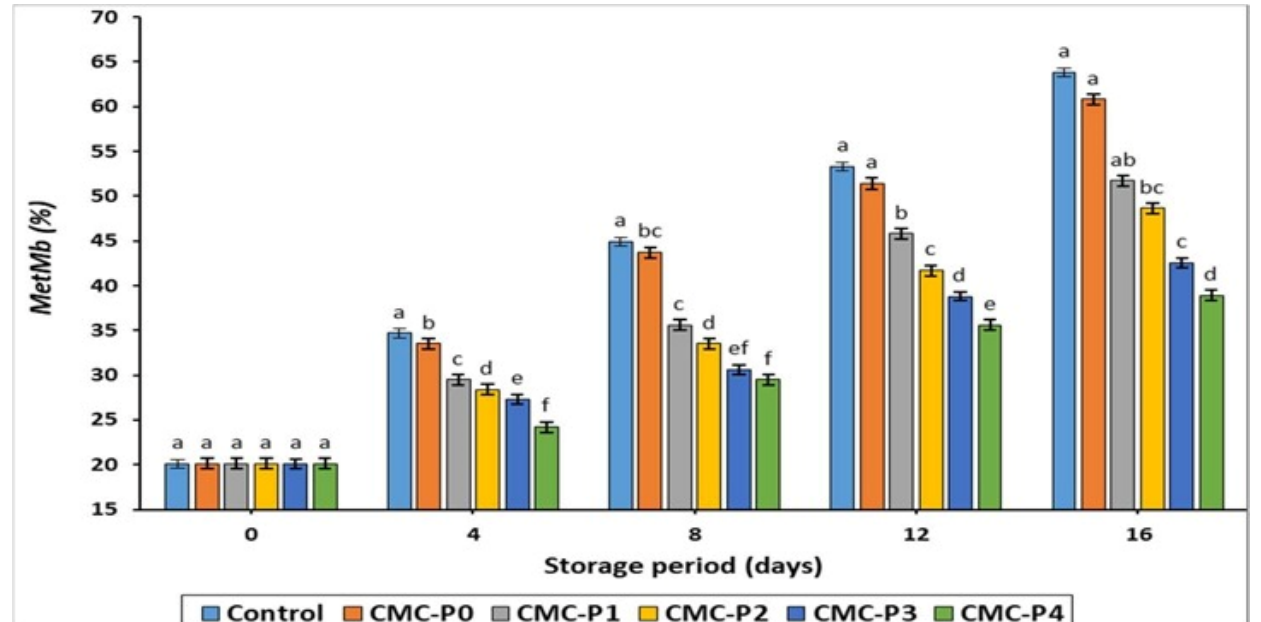
Figure 4. The impact of applied coatings on the MetMb (%) of chicken breast meat samples during storage at 2 °C for 16 days. Control : Uncoated chicken breast meat samples (soaked samples in sterile distilled water). CMC-P0 : CMC-coated chicken breast meat samples with 0% EPE. CMC-P1 : CMC-coated chicken breast meat samples with 1% EPE. CMC-P2 : CMC-coated chicken breast meat samples with 2% EPE. CMC-P3 : CMC-coated chicken breast meat samples with 3% EPE. CMC-P4 : CMC-coated chicken breast meat samples with 4% EPE. a – f : Within a column, different superscripts indicate significant differences ( p ≤ 0.05 ).